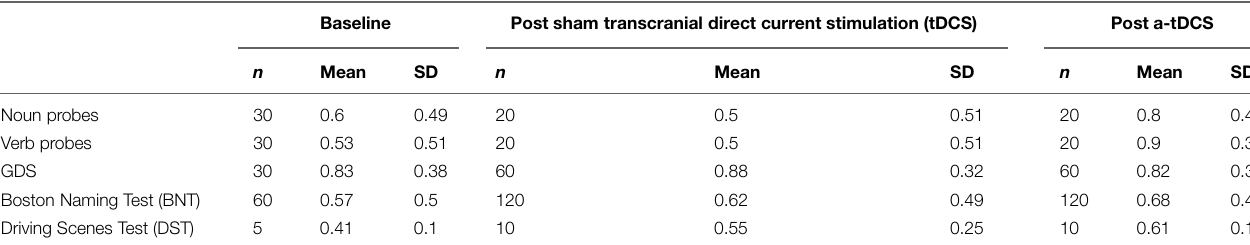
TABLE 3 | Mean task accuracy at three phases of testing.